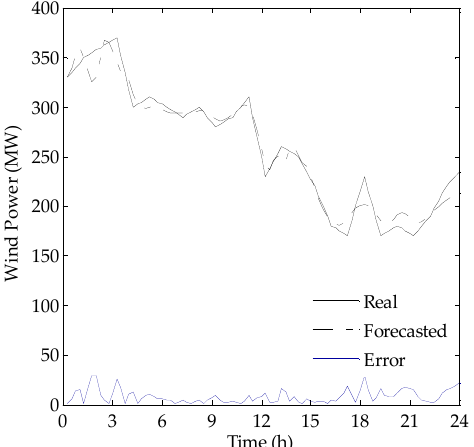
Figure 14. Real and forecasted wind power results (15 ‐ min intervals) for the Summer day.